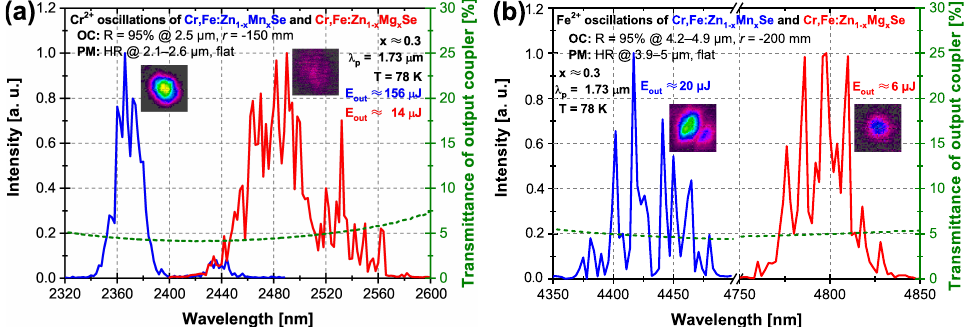
Figure 10. Laser oscillation spectra of the Cr 2 + and Fe 2 + ions of Cr,Fe:Zn 1 − x Mn x Se (x ≈ 0.3) (blue curves) and Cr,Fe:Zn 1 − x Mg x Se (x ≈ 0.3) (red curves) laser systems for the temperature of 78K, excited at the wavelength of λ p ≈ 1.73 µ m presented together with the output coupler transmittance (green curves) and the laser beam profile structure insets. ( a ) Directly excited Cr 2 + laser oscillation spectra. ( b ) Fe 2 + laser oscillation spectra excited via the Cr 2 + → Fe 2 + energy